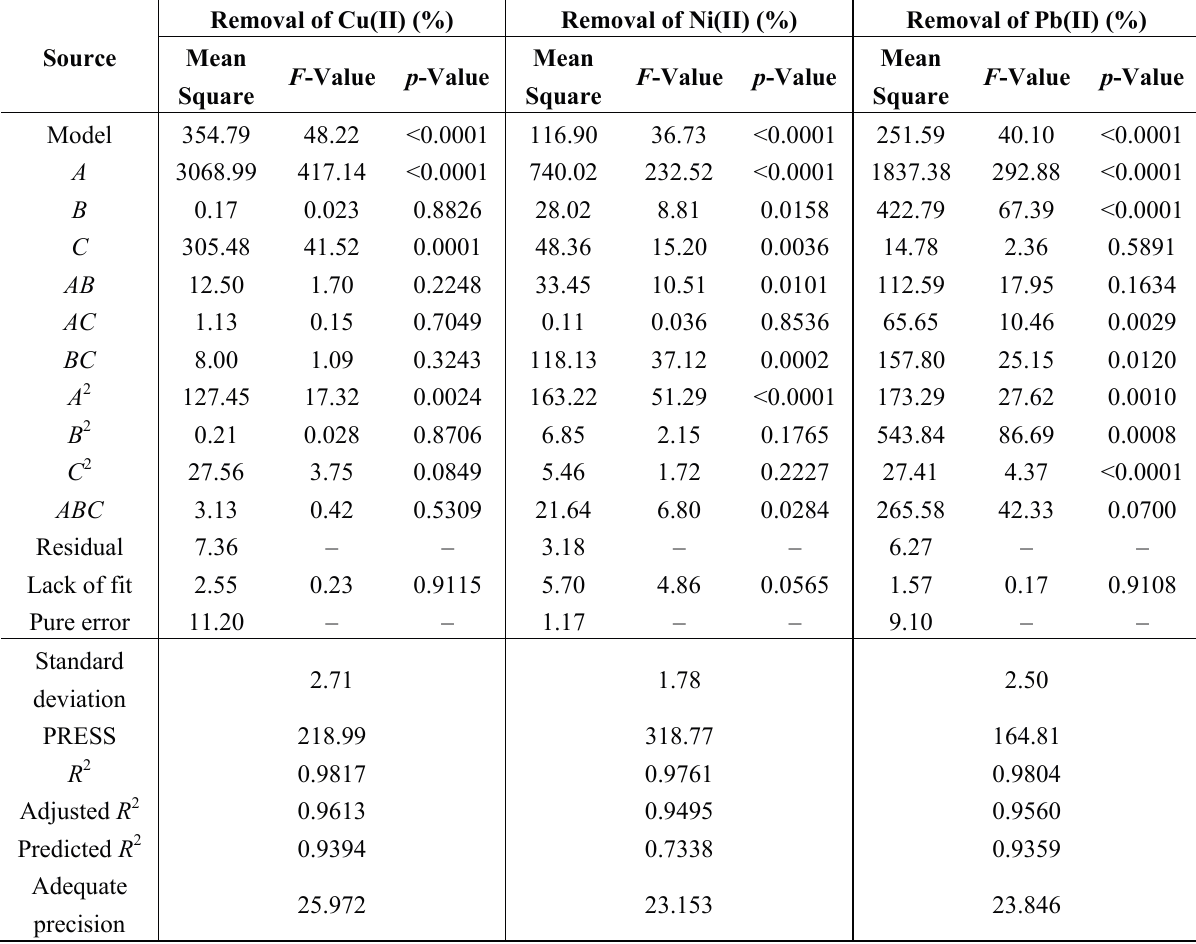
Table 3. Analysis of variance of the fitted quadratic equation and model summary statistics for removal% of Cu(II), Ni(II) and Pb(II); A , Initial ion concentration (mg/L); B , Removal time (s); C , Adsorbent dosage (g); PRESS, Predicted residual sum of